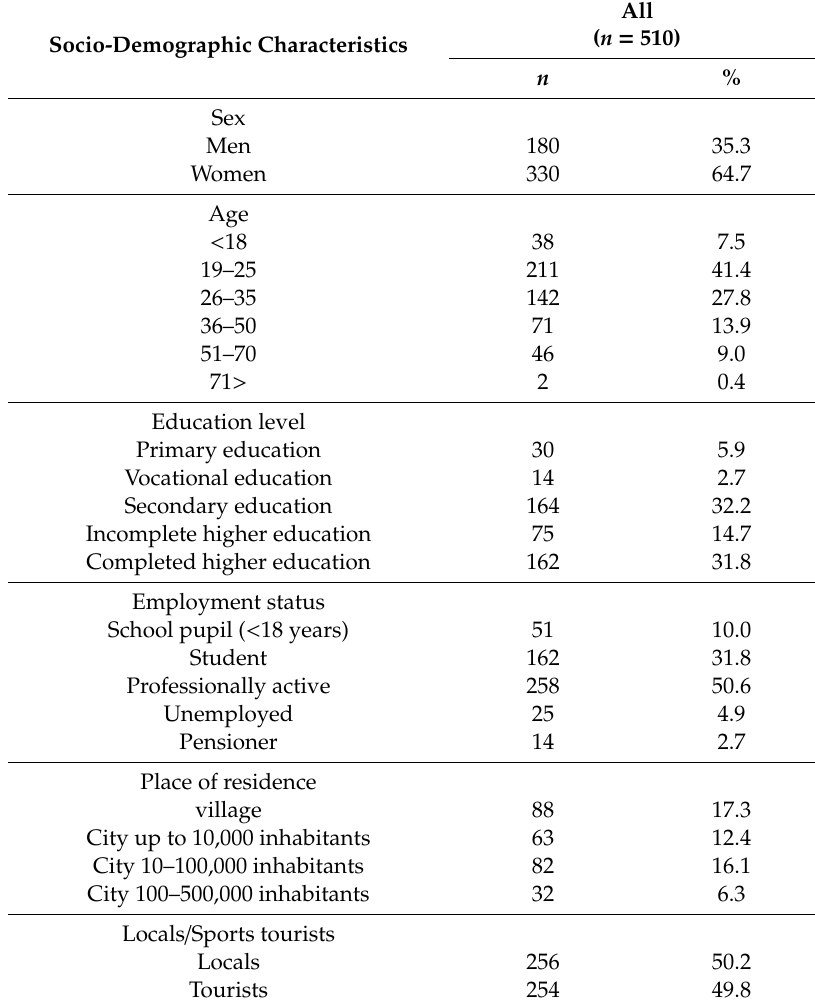
Table 1. Socio-demographic characteristics of